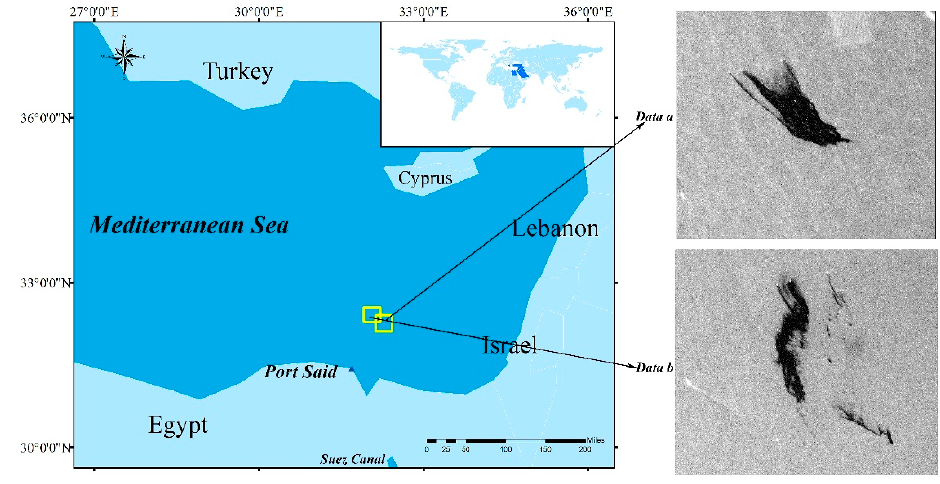
Figure 4. Study area.